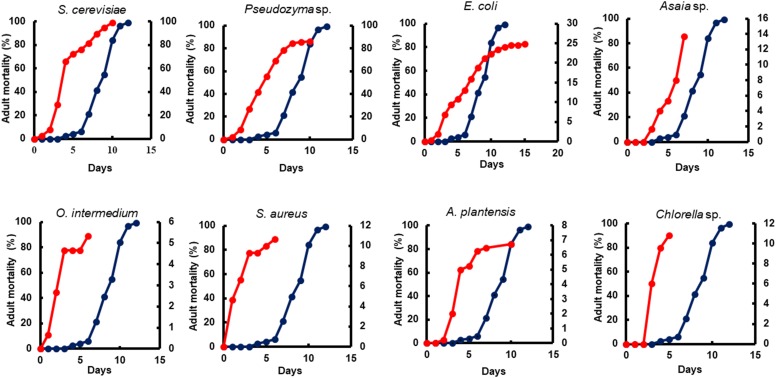
The impact of microorganism-based diet on adult survival. A representative survival curve comparing larvae fed with Tetramin (Dark blue line, left y-axis) and larvae fed with microbial cells (red line. Right y-axis). The dietary supply was administered only at L1. Survival was assessed daily.